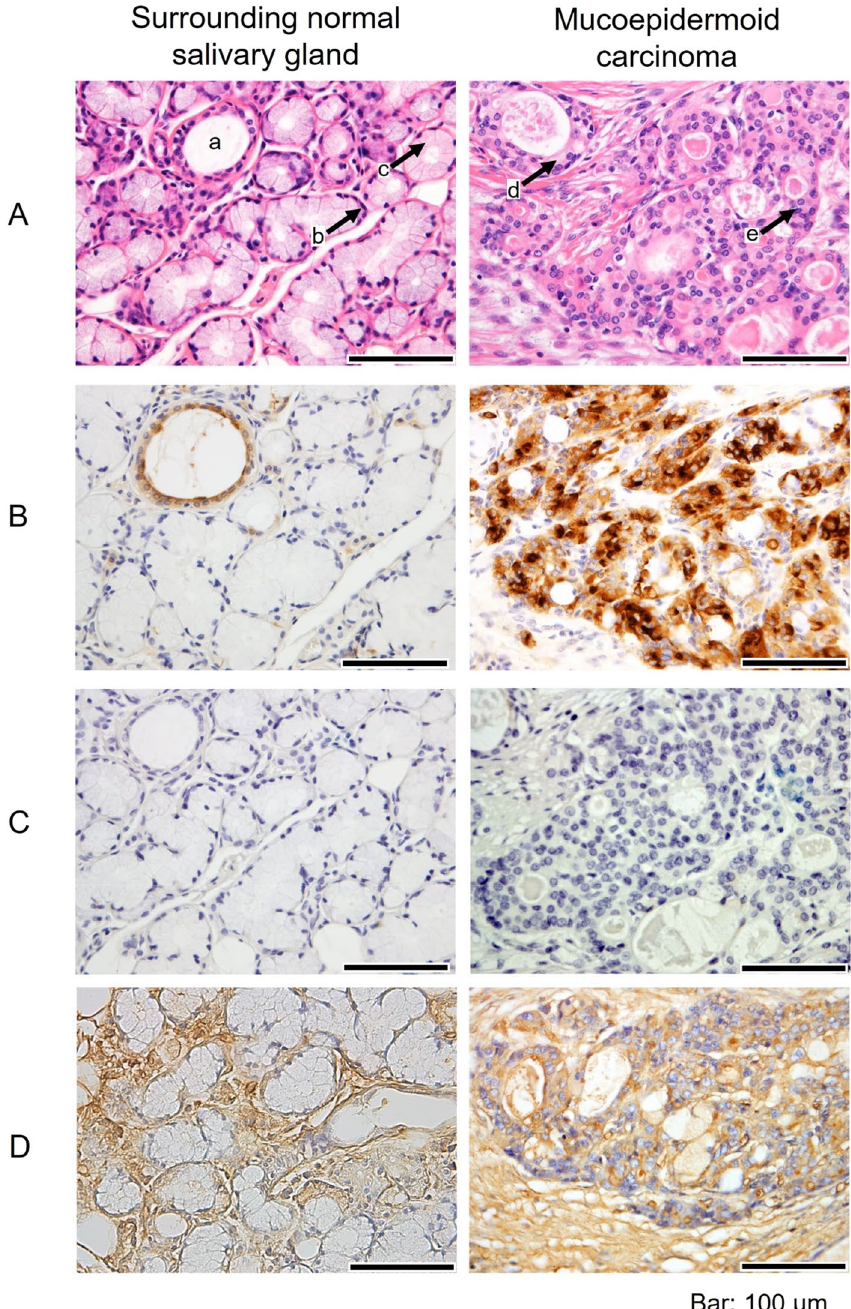
Figure 2. Comparison of the expression patterns of MUC1 and sialoglycans between MEC and its surrounding normal salivary gland. The representative images (original magnification, × 400) of H&E staining ( A ), staining with anti-MUC1 antibody ( B ), staining with anti-Sialyl-Tn antibody ( C ) and staining with MAL-II ( D ) are shown. Ducts (a), serous acini (b) and mucous acini (c) are indicated by H&E staining of the normal salivary gland, and mucous cells (d) and non-mucous cells (e) are indicated in H&E staining of the MEC ( A ). Scale bars indicate 100